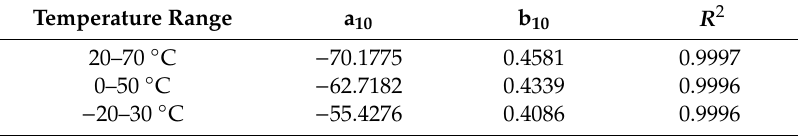
Table 2. Determination of coe ffi cients a 10 and b 10 for the Landsat 8 TIR Band